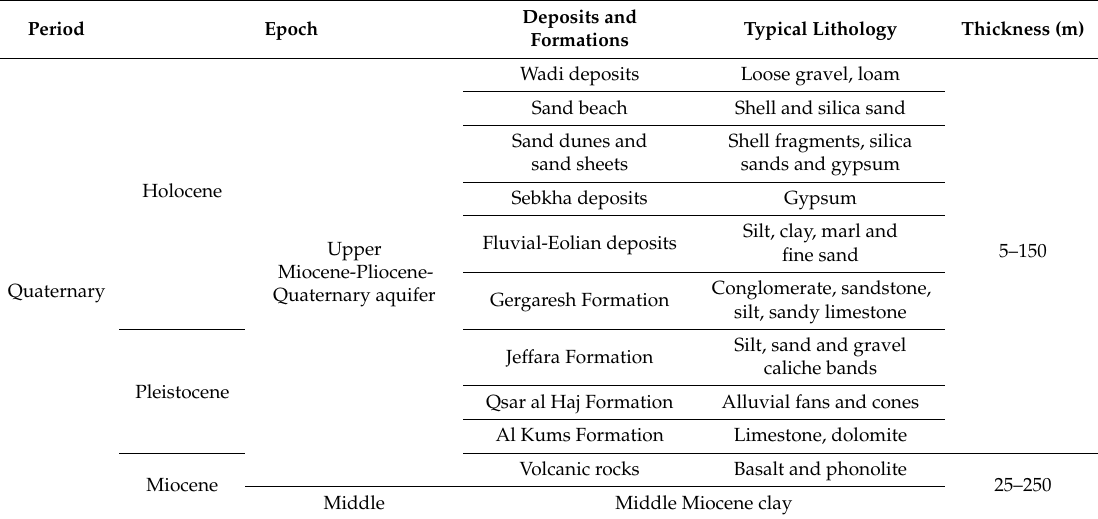
Table 1. Description of the Upper-Miocene-Pliocene-Quaternary deposits in the coastal area of Jifarah Plain around